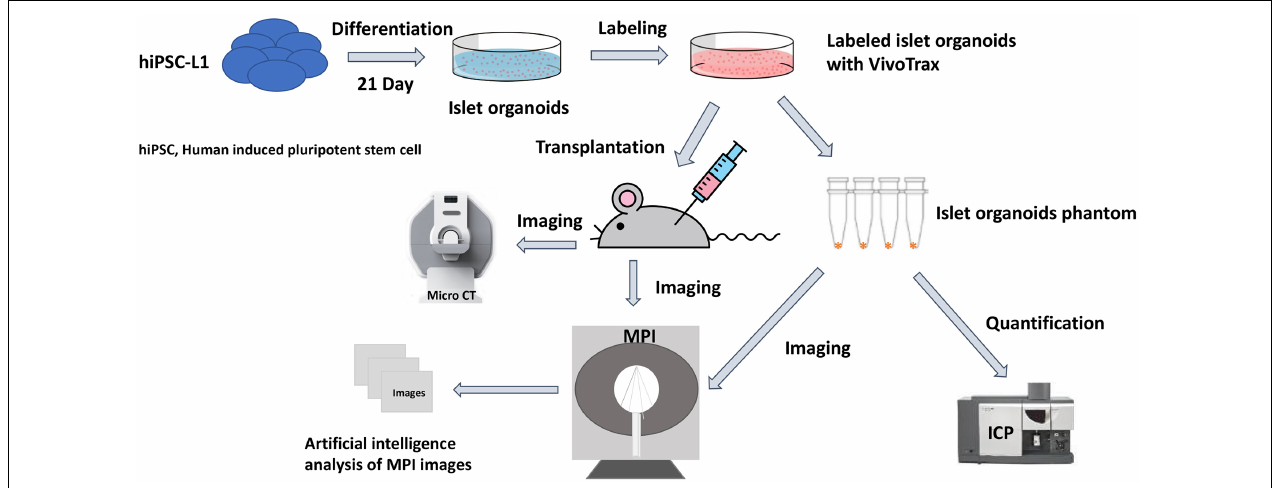
FIGURE 1 | Scientific method flow chart of the study. The goal of this study is to test a novel imaging method magnetic particle imaging (MPI) for quantifying stem cell derived islet organoids phantoms in vitro and monitoring of transplanted islet organoids in vivo . An artificial intelligence algorithm had been applied for segmentation and quantification of nanoparticle labeled islet organoids in mouse model. This paves the way for MPI to be used in stem cells transplantation therapies for